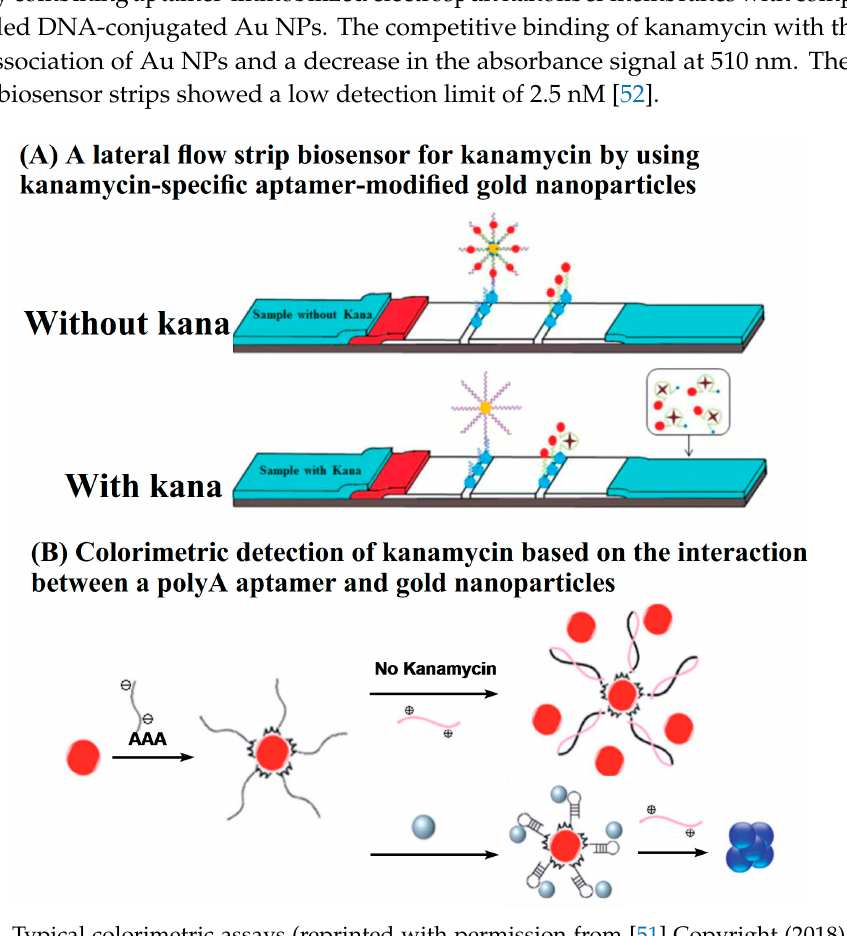
Figure 5. Typical colorimetric assays (reprinted with permission from [51] Copyright (2018) Royal Society of Chemistry and [53] Copyright (2020) Royal Society of Chemistry).